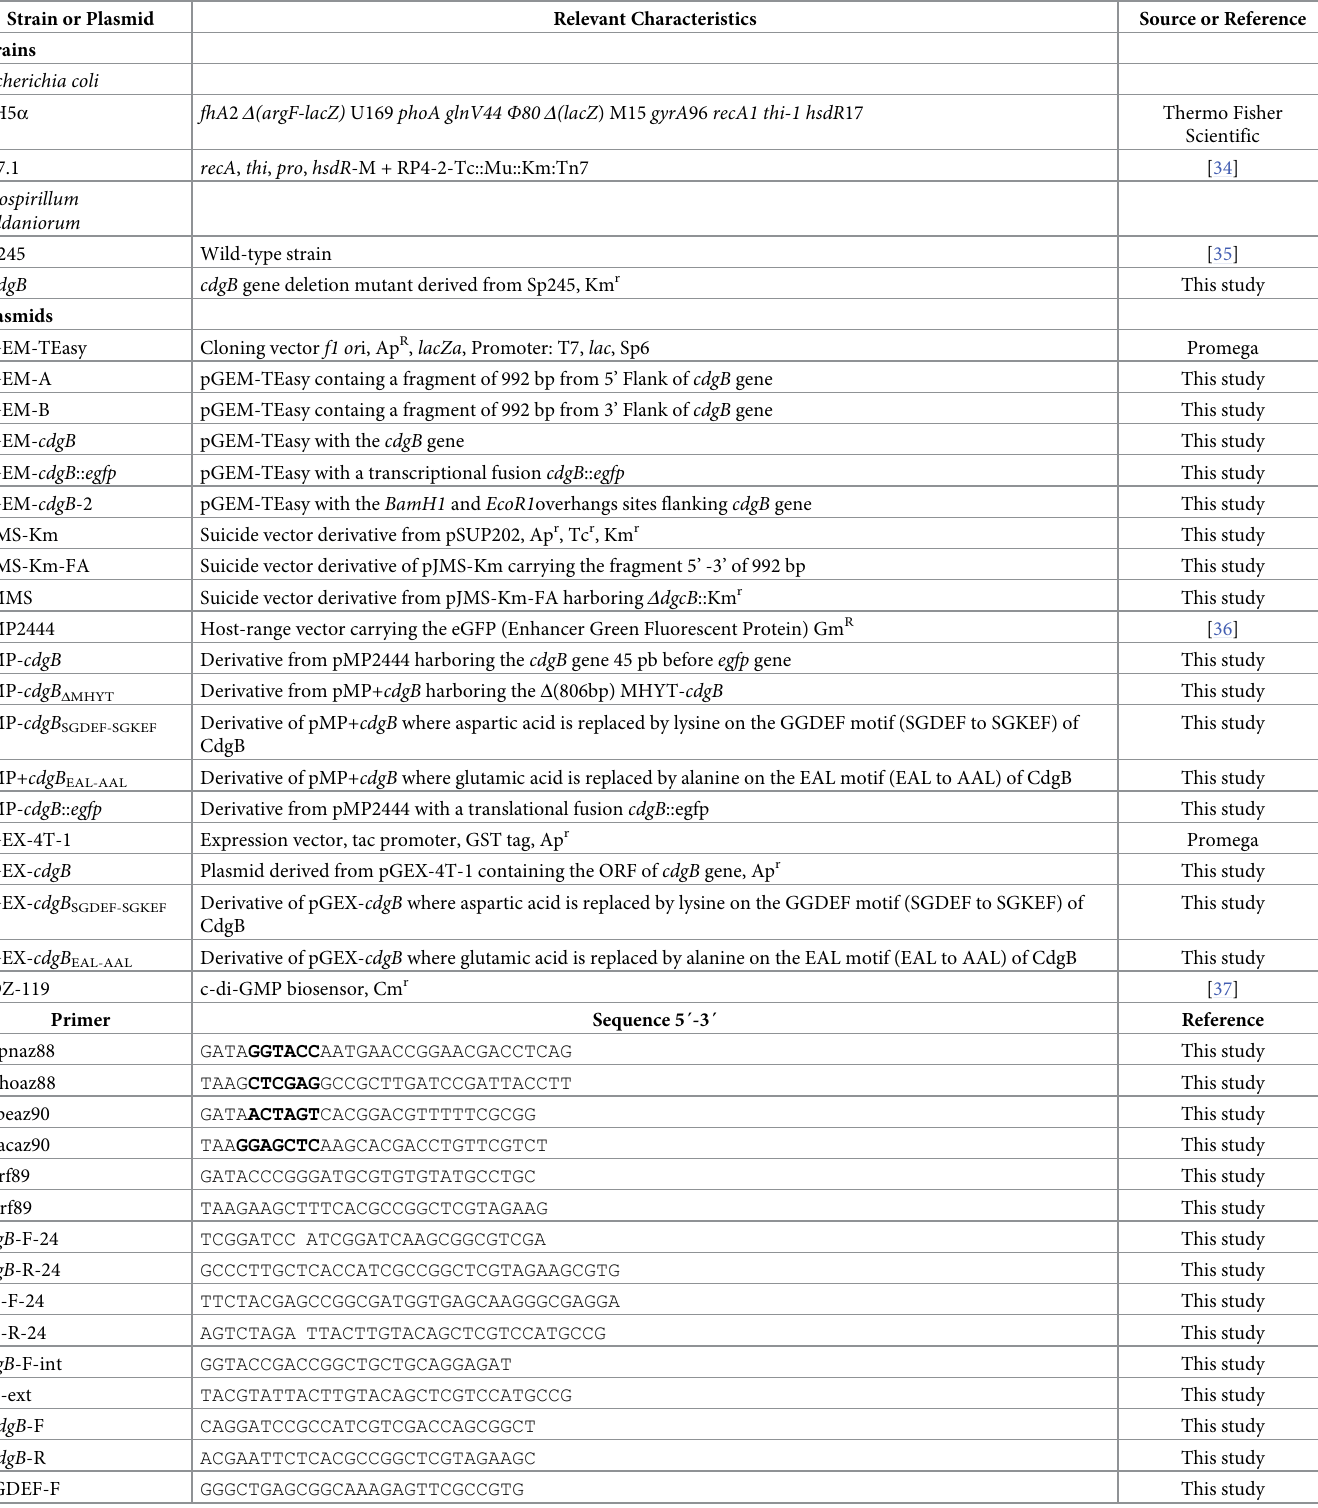
Table 1. Strains, plasmids, and primers. Strain or Plasmid Relevant